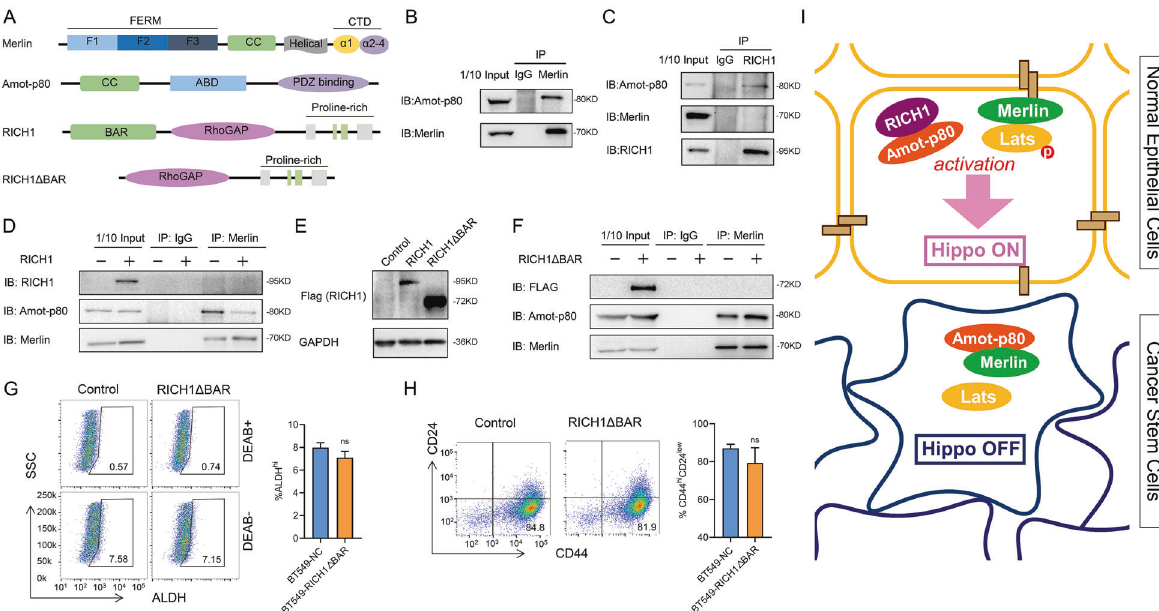
Fig. 7 RICH1 activates Hippo signaling by competing with Merlin for binding to Amot-p80. A Domain organizations of Merlin, Amot-p80, RICH1 and RICH1 △ BAR. B Co-IP analysis of Merlin-Amot-p80 interaction in BT549 cells. C Co-IP analysis of interaction between RICH1, Amot- p80 and Merlin in RICH1-overexpressing BT549 cells. D Co-IP analysis of interaction between Merlin and Amot-p80 in control and RICH1- overexpressing BT549 cells. E Overexpression of RICH1 and RICH1 △ BAR (truncation mutant of RICH1 lacking the N-terminal BAR domain) in BT549 cells. F Co-IP analysis of interaction between Merlin and Amot-p80 in control and RICH1 △ BAR-overexpressing BT549 cells. G, H Flow cytometry analysis and representative images of ALDH hi ( G ) and CD44 + CD24 − ( H ) subpopulations in BT549 cells. Numbers in the fl ow cytometry charts indicate the CSC percentages. I Schematic model of the role of RICH1 in BCSC regulation. The experiments were repeated three times independently with similar results. Data represent mean ± SD. Statistical signi fi cance was determined by two-tailed unpaired t - test. Abbreviation: ns not signi fi